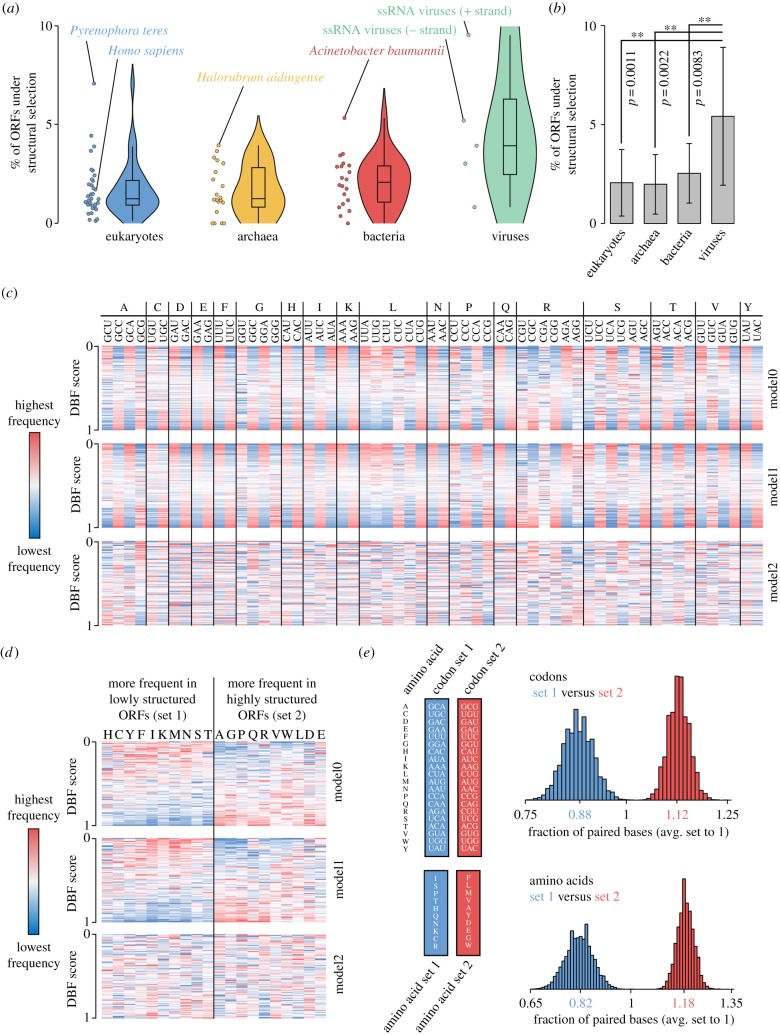
(a) Estimation on the fraction of ORFs under structural selection. (b) Virus ORFs are significantly more often under structural selection. p-values represent two-tailed p-values from unpaired t-tests. Error bars refer to standard deviation. (c) Codon frequencies in ORFs sorted by DBF score. Data exemplarily taken from Mus musculus. (d) Amino acid frequencies in ORFs sorted by DBF score. Data exemplarily taken from M. musculus. (e) Structuring of ORFs that code for identical peptide sequences but use different sets of codons (top) and structuring of ORFs that code for peptides being composed of different sets of amino acids (bottom).